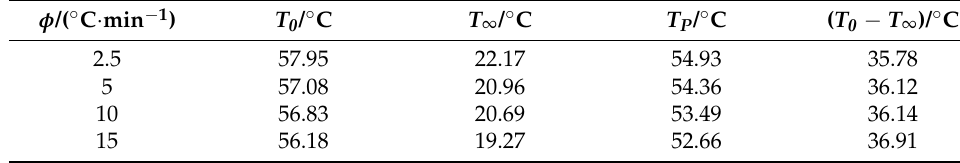
Table 8. The non-isothermal crystallization parameters of VGO4.